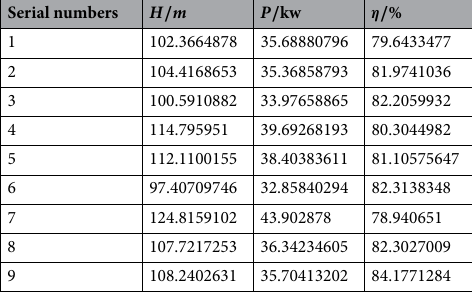
Table 4. Orthogonal test results.